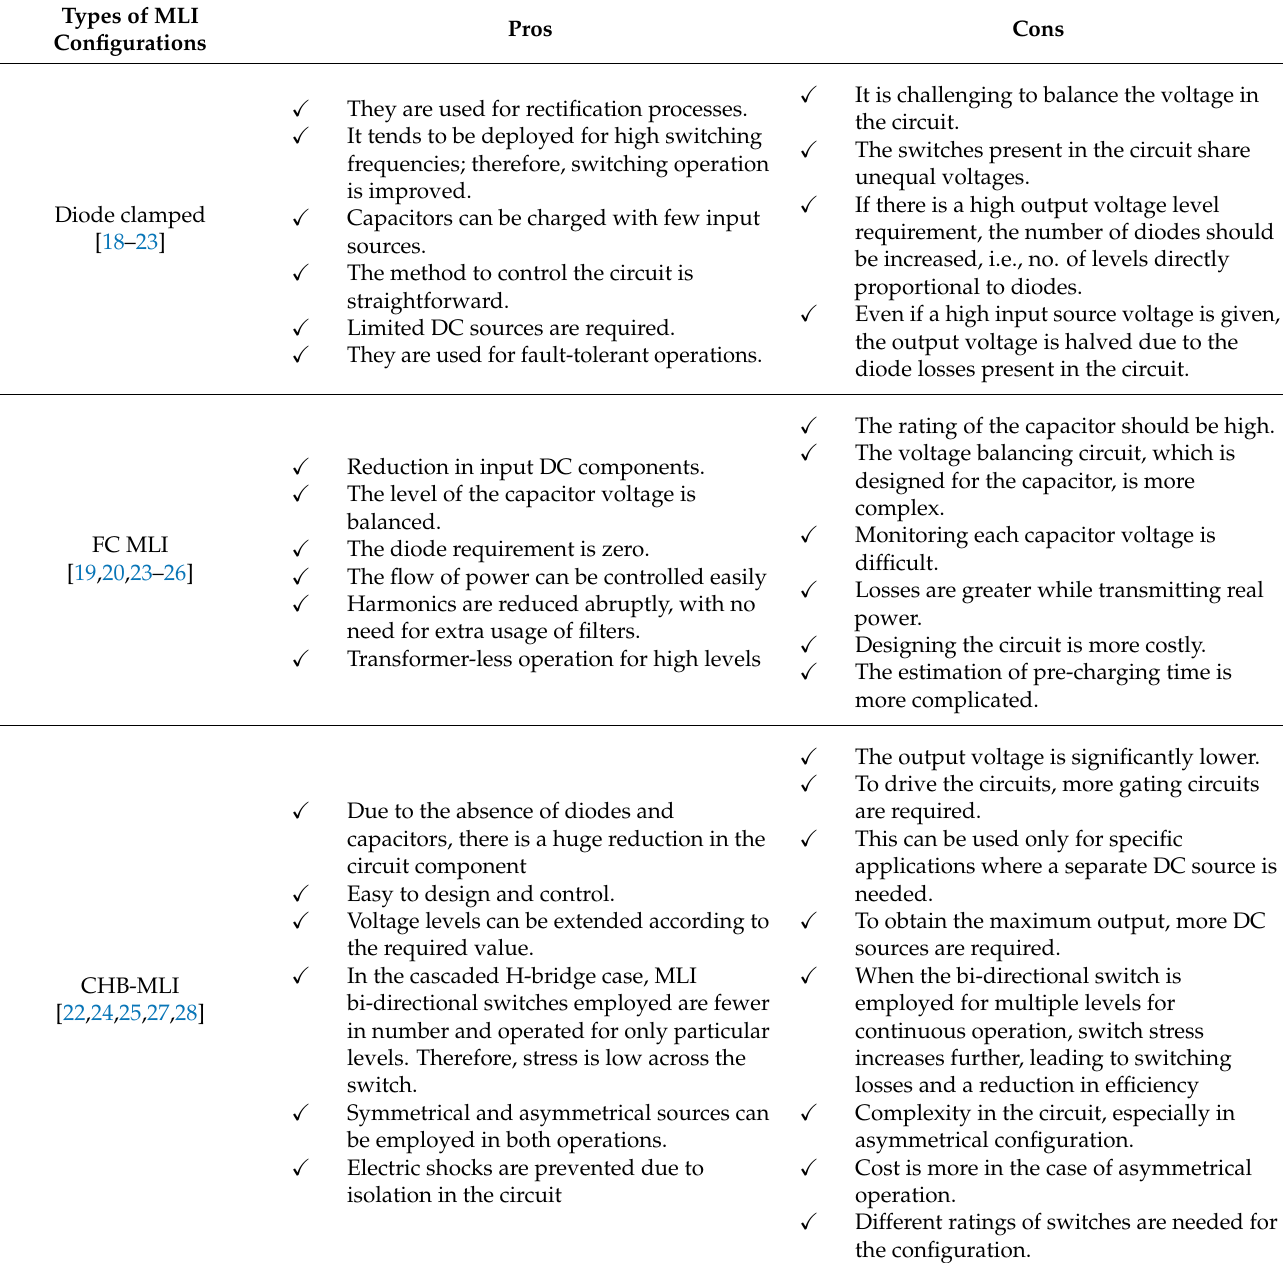
Table 1. Pros and Cons regarding different Multilevel